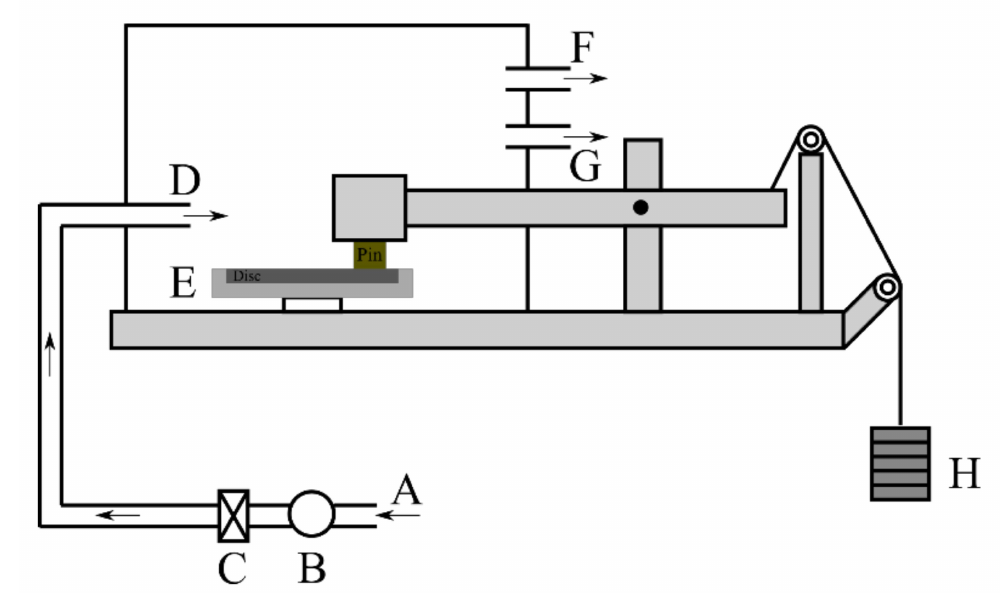
Figure 4. Schematics of the testing apparatus ( A ) ambient air, ( B ) fan, ( C ) HEPA filter, ( D ) air introduced in the chamber, ( E ) disc/counterface, ( F ) air outlet to the Impactor, ( G ) air outlet to the OPS, and ( H )